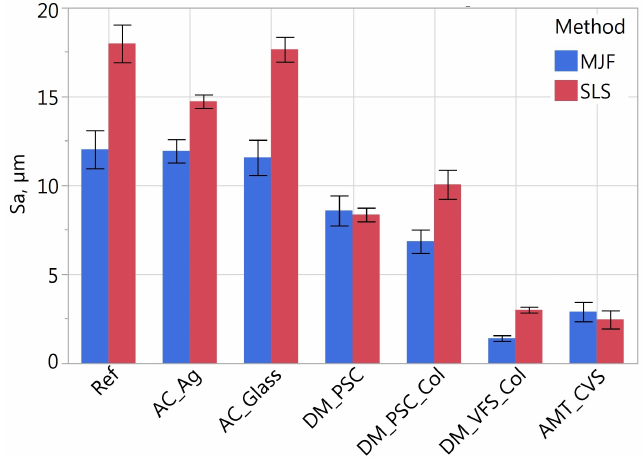
Figure 11. Arithmetical mean height Sa of measured